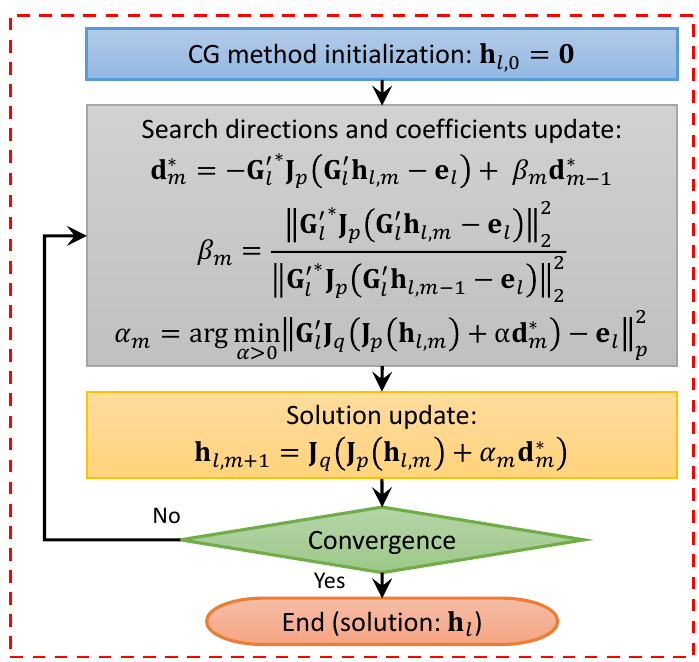
Figure 3. Flow-chart of the internal loop of the algorithm employed for the quantitative characterization of dielectric